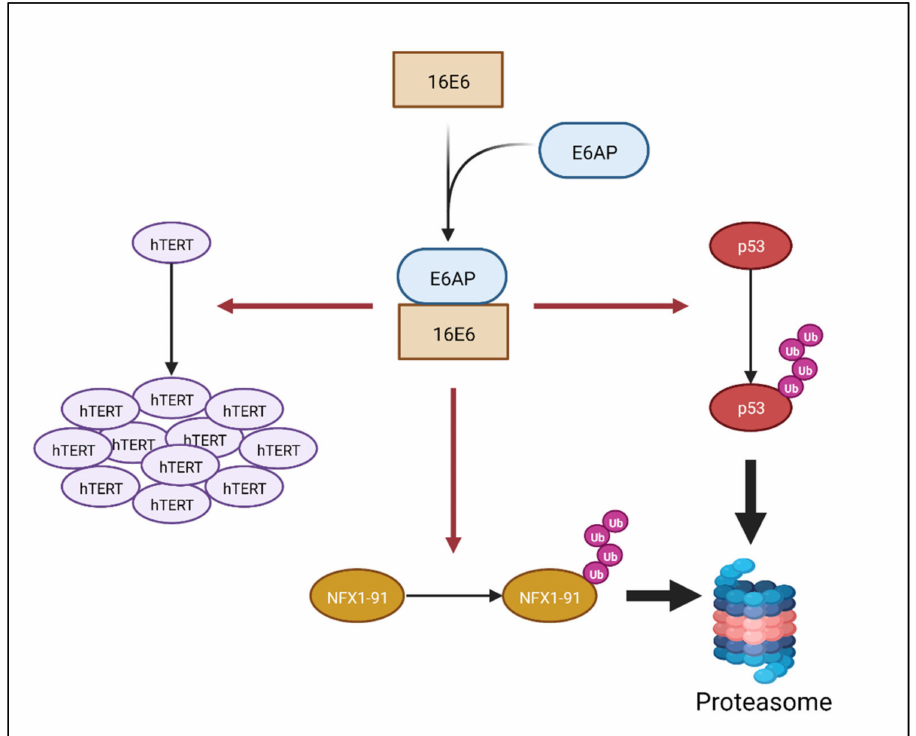
Figure 1. Some of the known functions of HPV 16E6 . HPV 16E6 partners with the cellular protein E6AP, which enables the oncoprotein to polyubiquinate cellular proteins, such as p53 and NFX1-91. In partnership with E6AP, 16E6 has also been shown to increase telomerase activity by increasing the expression of hTERT, the catalytic and rate-limiting subunit of telomerase. Figure created with